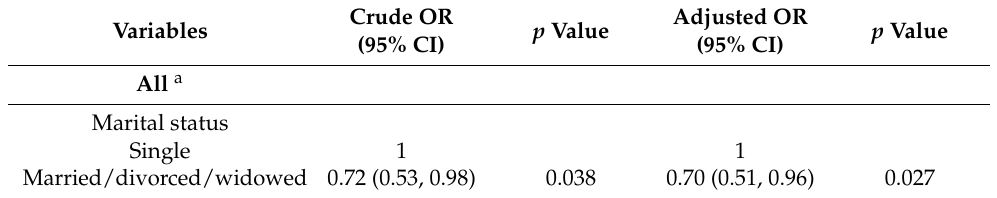
Table 3. Factors associated with total delays in pulmonary tuberculosis treatment by